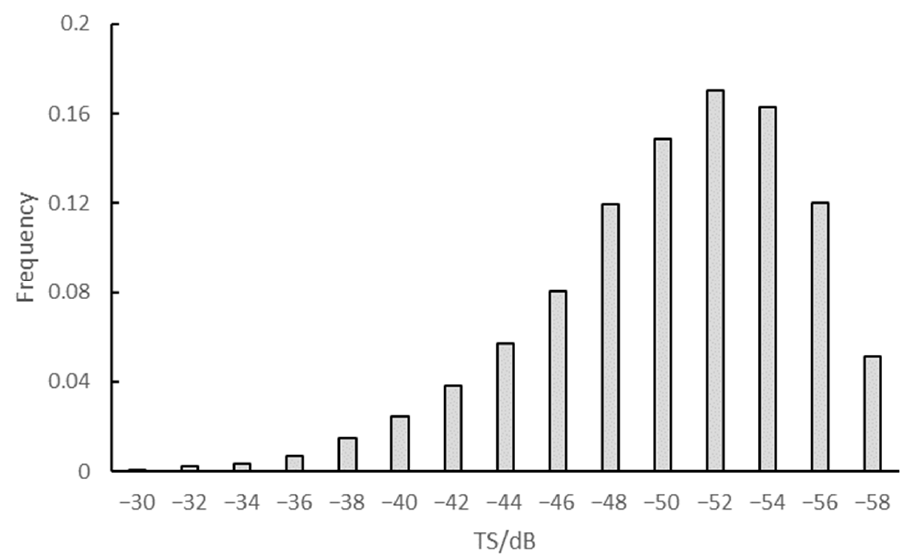
Figure 2. Distribution of Target Strength